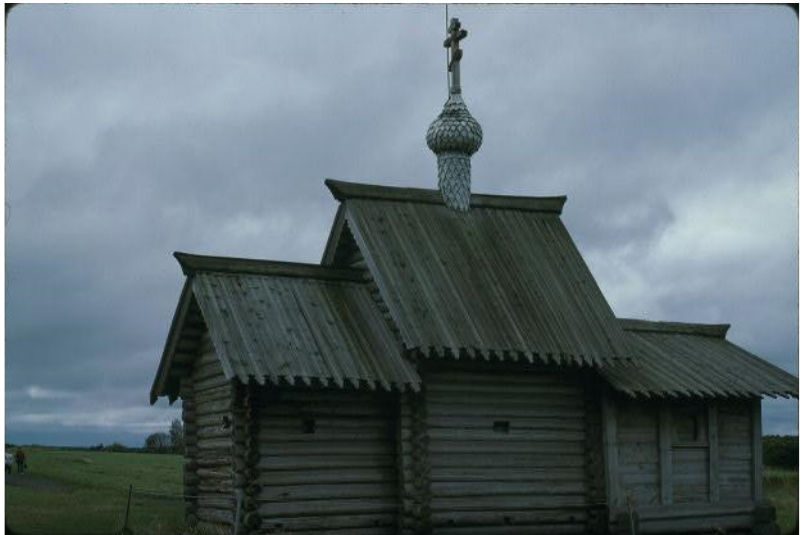
Figure 4. Church of the Resurrection of Lazarus, northeast view, at the Kizhi State Open Air Museum of History, Architecture, and Ethnography. Photograph by William Brumfield in the collection of the Library of Congress (Brumfield 1988).